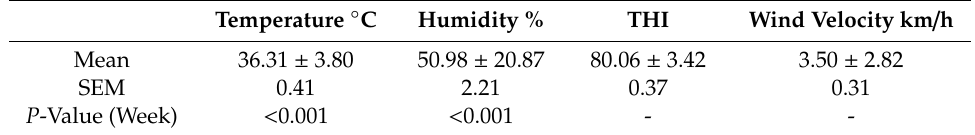
Table 2. Daily peak 1 shed temperature, humidity, THI 2 , and wind velocity during the experimental